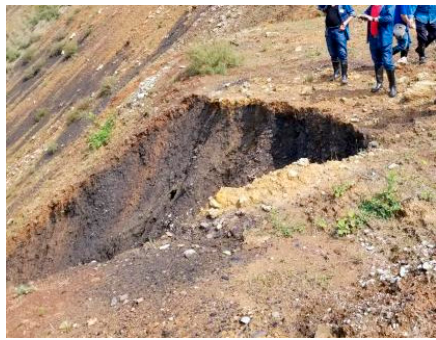
Figure 2. Status of No. 3 gully.